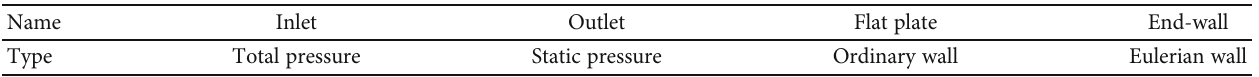
Figure 3: Grid dependency checking by velocity pro fi les in typical condition. Table 2: Boundary